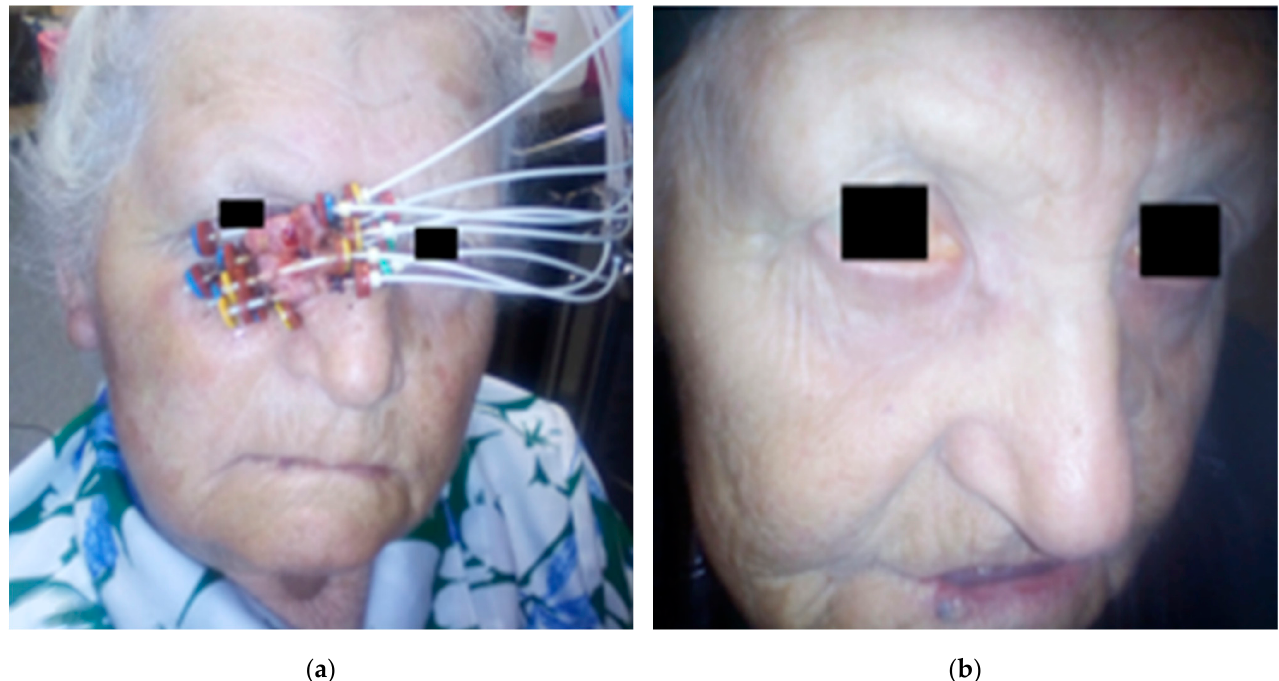
Figure 1. ( a ) Patient, age 80, basal cell carcinoma of the lower eyelid and medial canthus of the right eye. Applicators placed in the tumor; ( b ) the same patient, six months after the end of treatment.